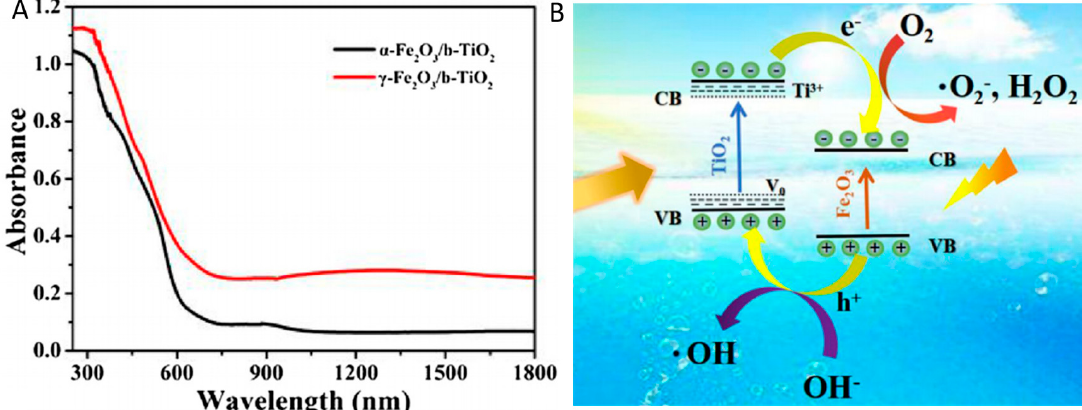
Figure 13. ( A ) UV-vis spectra; ( B ) Proposed band alignment and charge transfer mechanism. Reprinted with permission for ref. [59]. Copyright 2019, Elsevier.